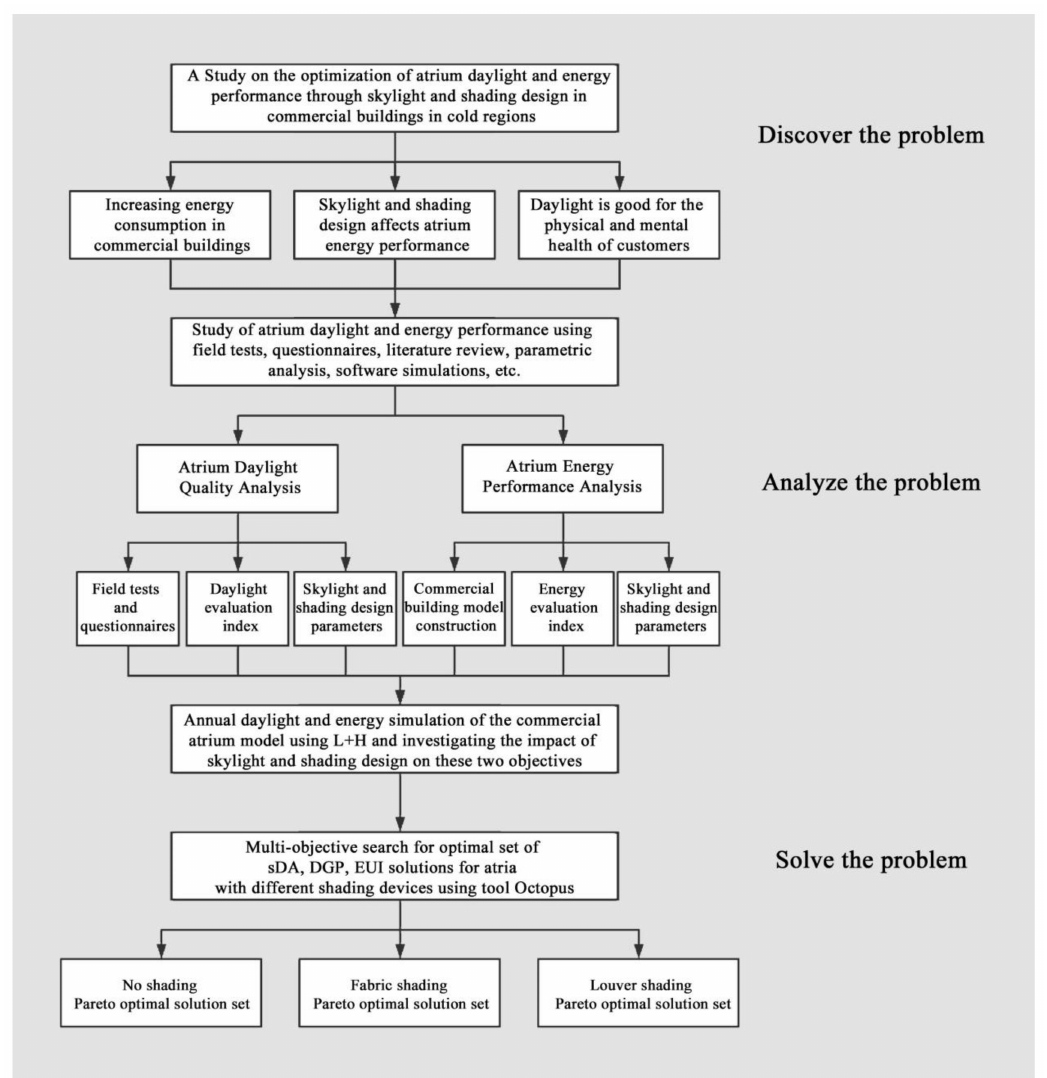
Figure 2. Technology research